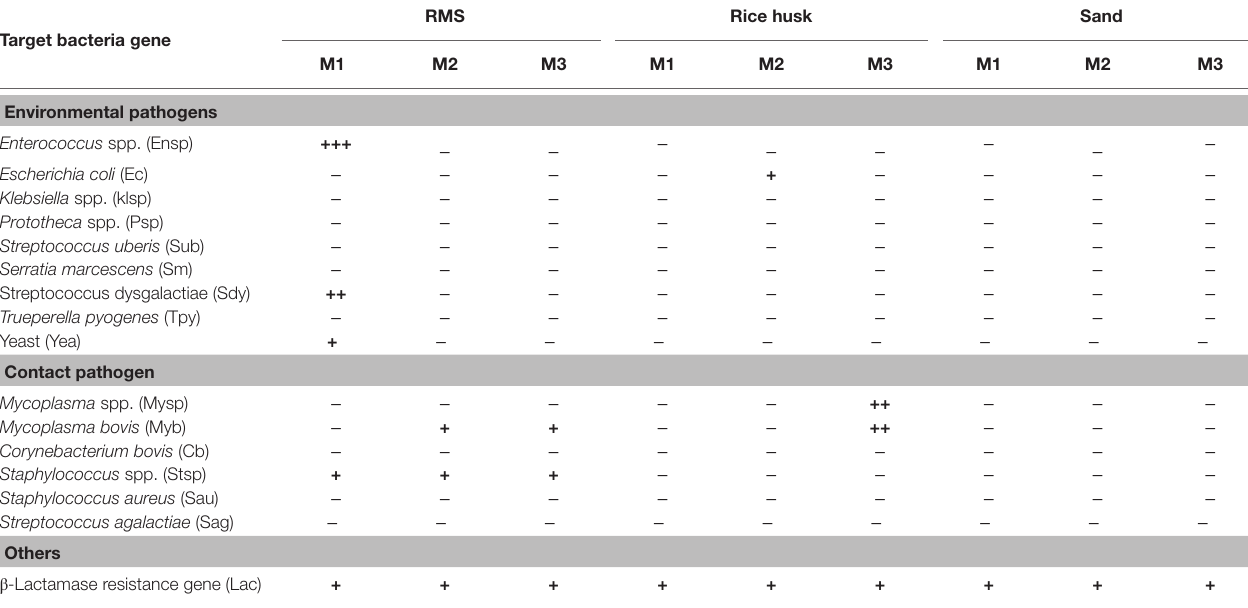
TABLE 4 | Detection of pathogenic bacteria in milk samples by